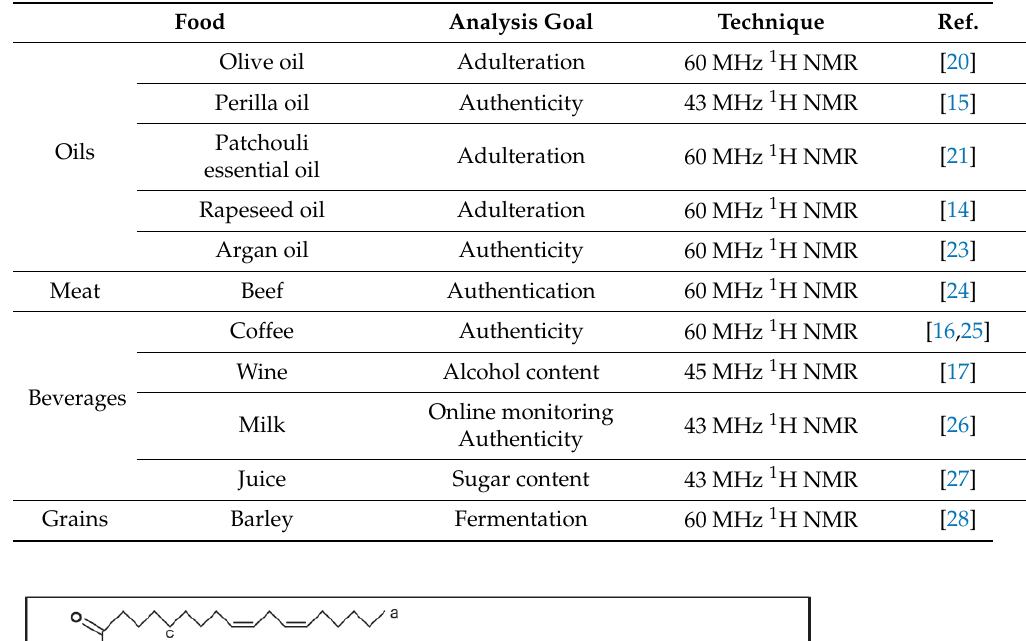
Table 1. Applications of benchtop nuclear magnetic resonance (NMR) spectroscopy to the analysis of foods.